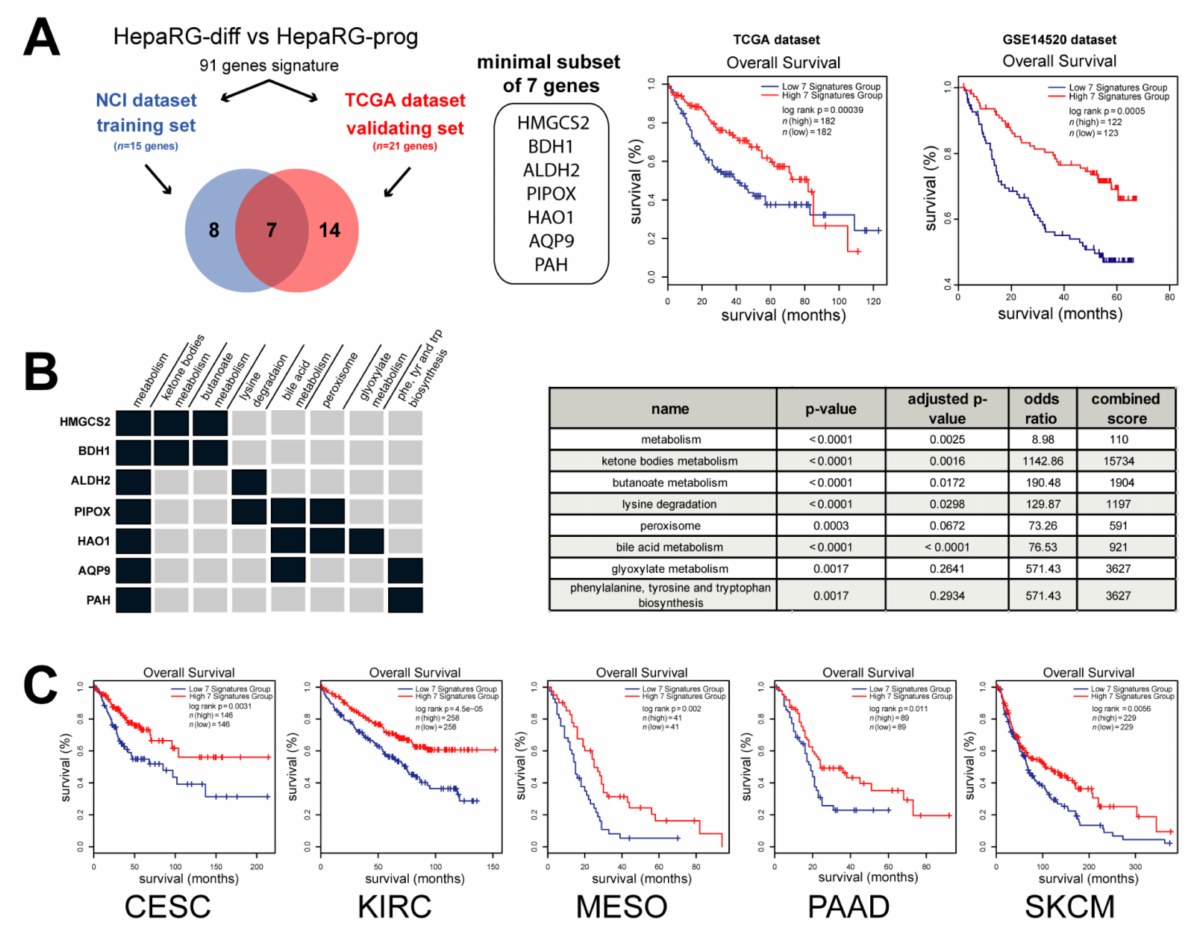
Figure 5. A minimal subset of 7 metabolic genes predicts a poor prognosis in cancer. ( A ) Analysis of genes from the HepaRG signature described in Figure 4 associated with the overall survival (OS) in two independent datasets: NCI ( n = 15 genes) and TCGA ( n = 21 genes). Survival analysis unraveled a minimal subset of 7 genes negatively correlated with patient outcome in two distinct datasets (i.e., TCGA, n = 364 HCC and GSE14520, n = 245 HCC). ( B ) Data mining analysis using Enrichr [30] demonstrated that the 7 genes were significantly associated with metabolism, such as ketone bodies, butanoate, bile acid and glyoxylate metabolisms, as well as lysine degradation, peroxisome and Phe, Tyr and Trp biosynthesis ( p value < 0.01) ( C ) Analysis of overall survival by Kaplan–Meier plot and log-rank statistics in several cancers from TCGA, including cervical squamous cell carcinoma (CESC), kidney renal clear cell carcinoma (KIRC), mesothelioma (MESO), pancreatic adenocarcinoma (PAAD) and skin cutaneous melanoma (SKCM). Patients were divided into two groups based on the expression of the 7 genes taken as a signature (blue curve: low expression; red curve: high